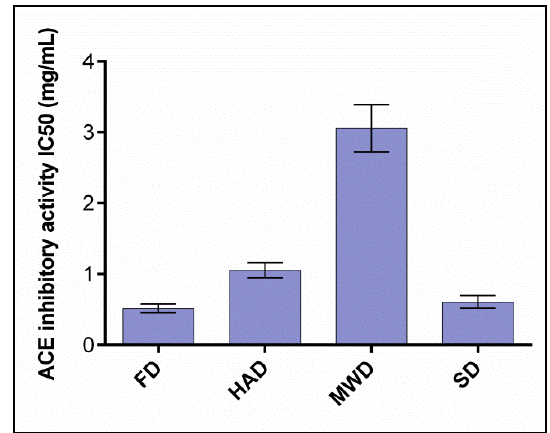
Figure 7. ACE inhibitory activity IC50 (mg / mL) of dry fruit bodies Pleurotus ostreatus after in